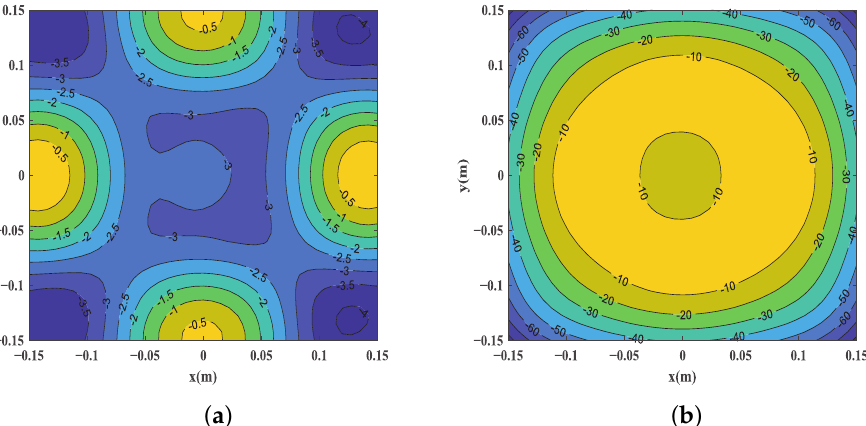
Figure 7. Simulated electric-field intensity distribution of QZ center at 26 GHz: ( a ) amplitude distribution and ( b ) phase